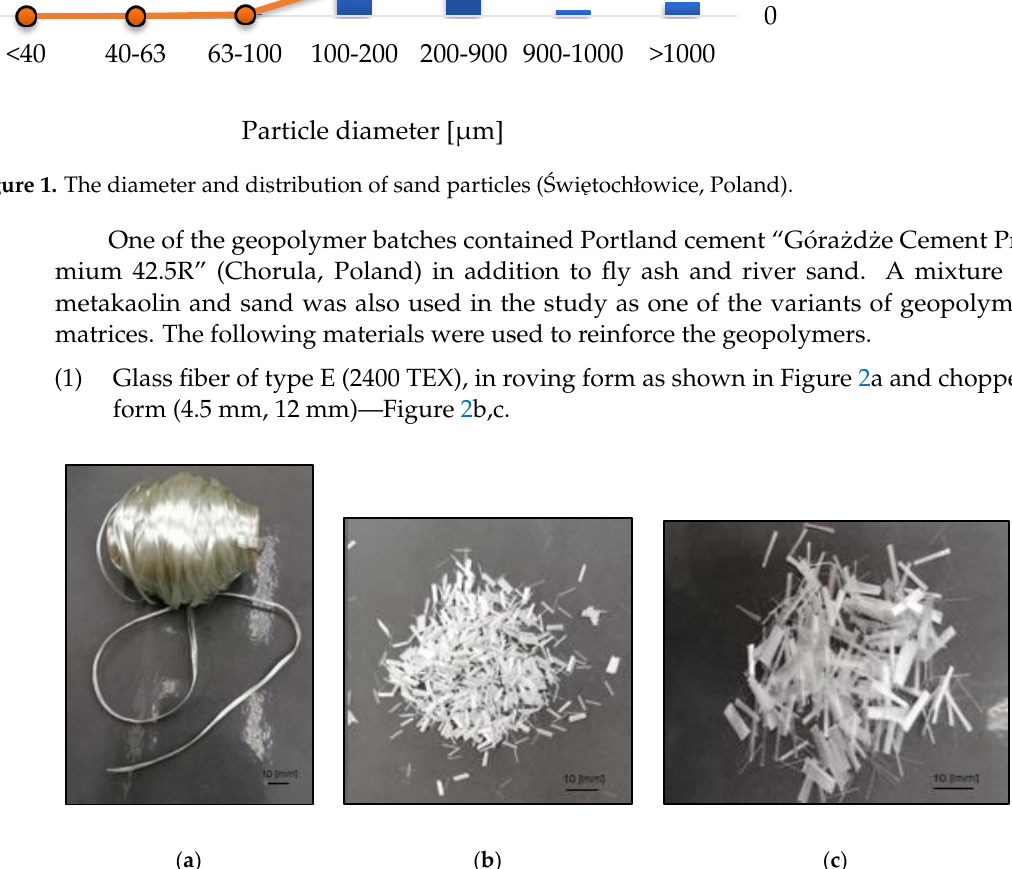
( b ) Figure 3. Carbon fiber: ( a ) in continuous form; ( b ) cut into 5 mm lengths. (3) Basalt grid — Deutsche Basalt Faser GmbH, (Sangerhausen Germany) shown in Figure 4, 10 mm × 15 mm mesh; one or two layers of reinforcement in geopolymer. Figure 4. Basalt grid — mesh size 10 mm × 15 mm. The alkaline activator was a solution of 5 M and 10 M sodium hydroxide and R-145 sodium hydroxide with a molar modulus of 2.5 and density of about 1.45 g/cm 3 . The so- lutions were prepared according to the scheme: flakes of technical hydroxide were dis- solved in water, and then, an aqueous solution of sodium silicate was added. The ratio of sodium hydroxide solution to sodium water glass was 1:2.5 by weight in each case. The